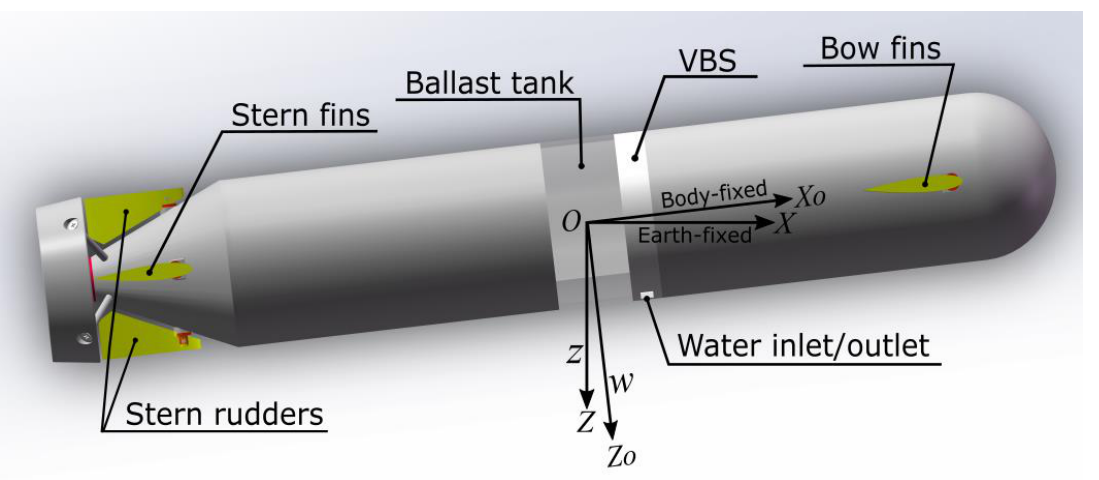
Figure 1. A typical configuration of an autonomous underwater vehicle (AUV) equipped with a variable ballast system (VBS) and bow and stern fins.